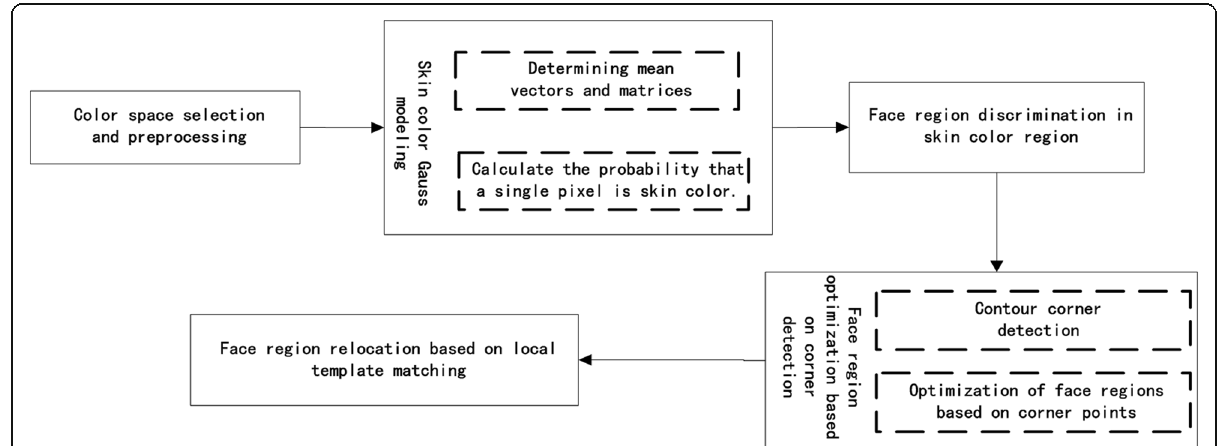
Fig. 5 Algorithm flow based on skin color